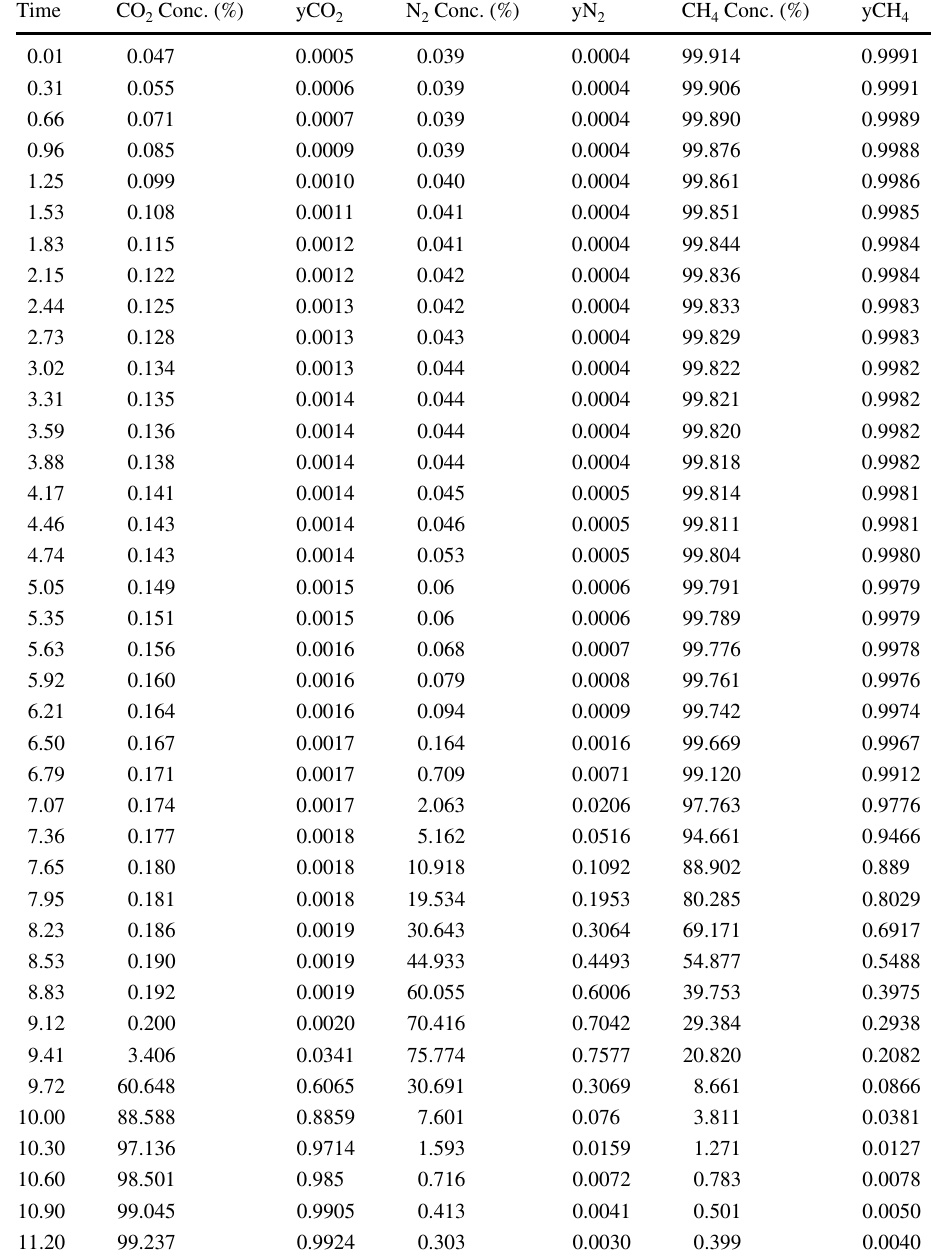
Table 9 Effluent concentrations at 5 PV of cushion gas